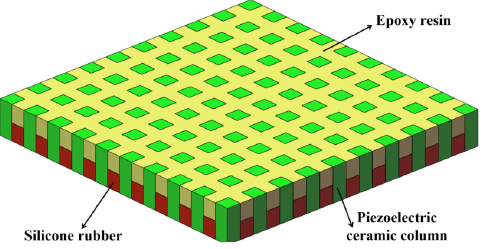
Figure 1. Planar three-phase piezoelectric composites structure.